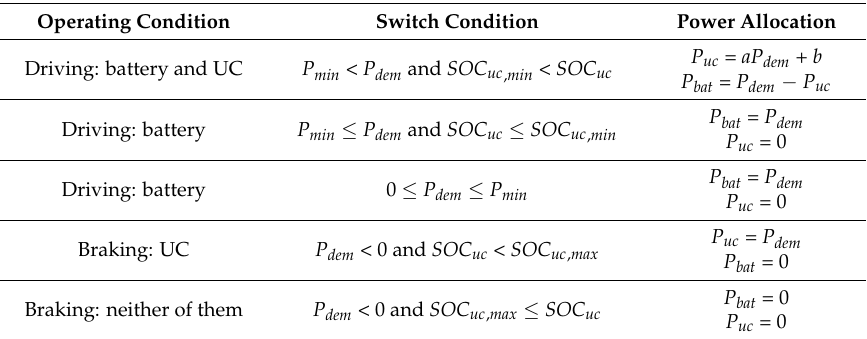
Table 4. Adaptive rule-based controller. SOC—state of change;